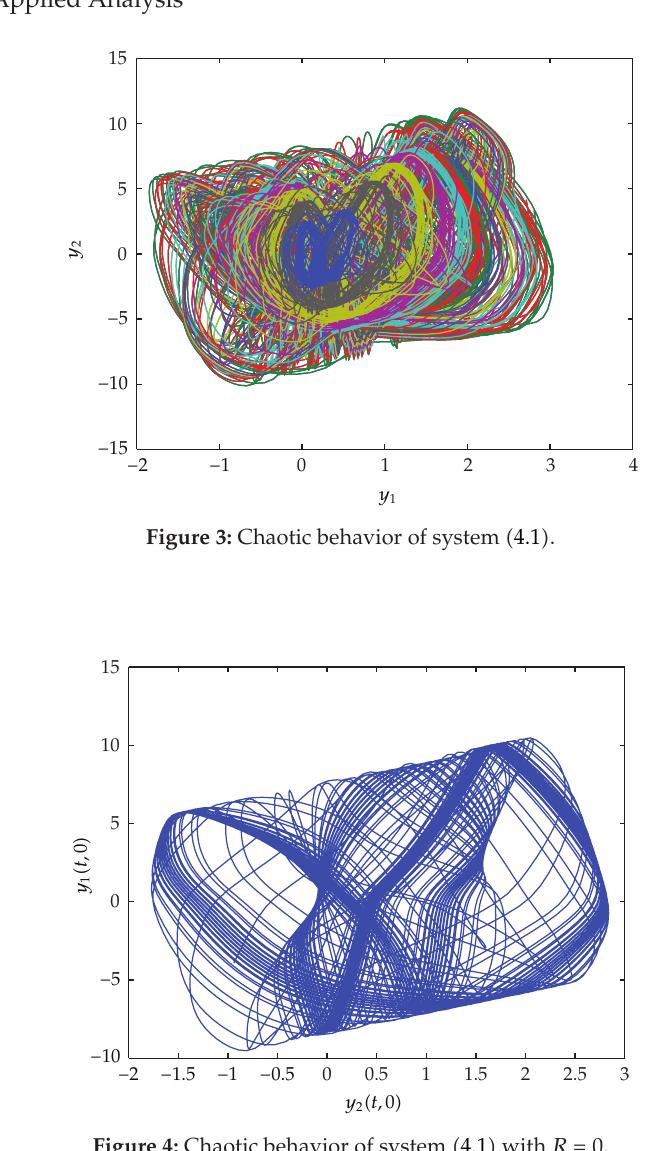
Figure 4: Chaotic behavior of system (cid:6) 4.1 (cid:7) with R (cid:9)